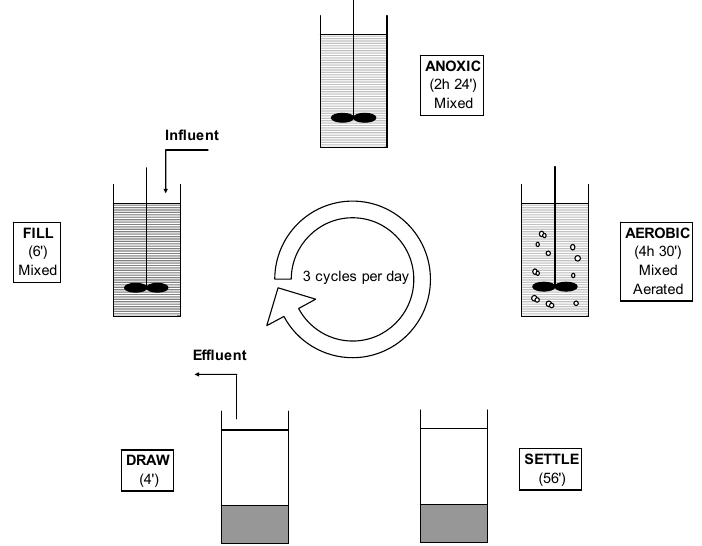
Figure 1. Operating sequences of SBR system during one complete cycle (8